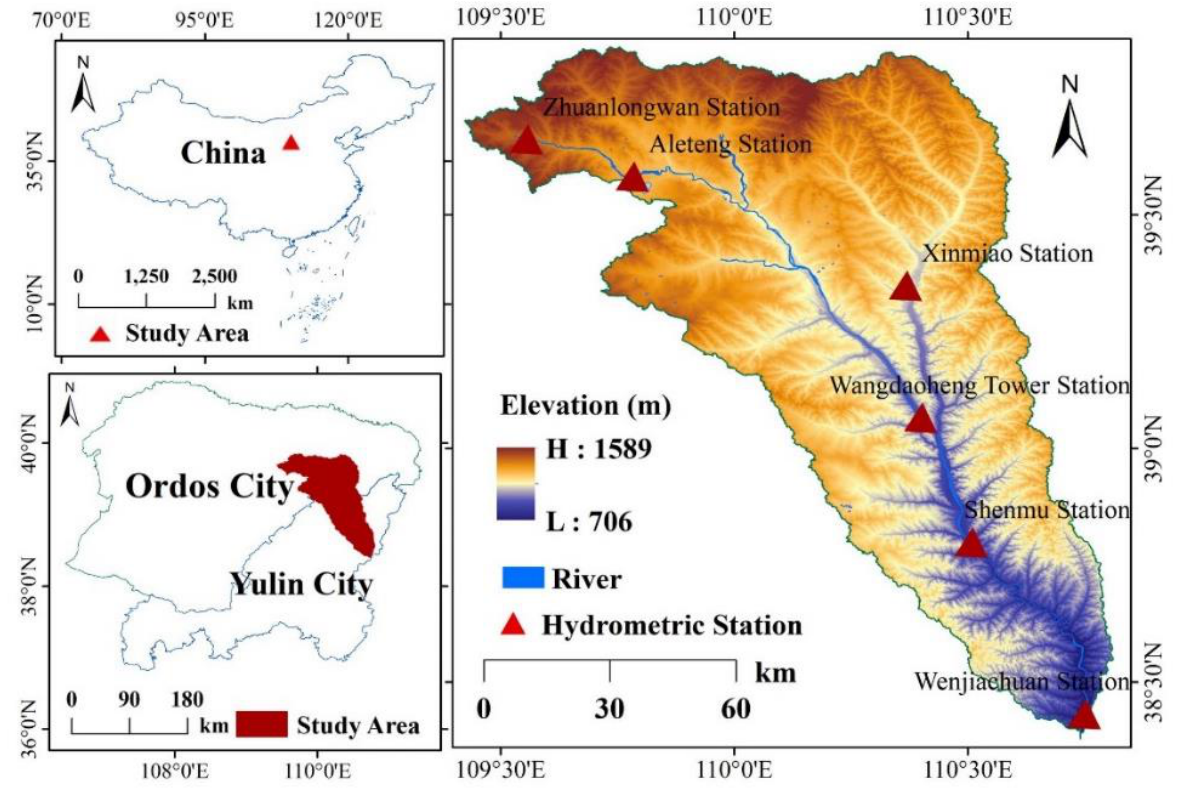
Figure 1. A map displaying the location of the Kuye River Basin.